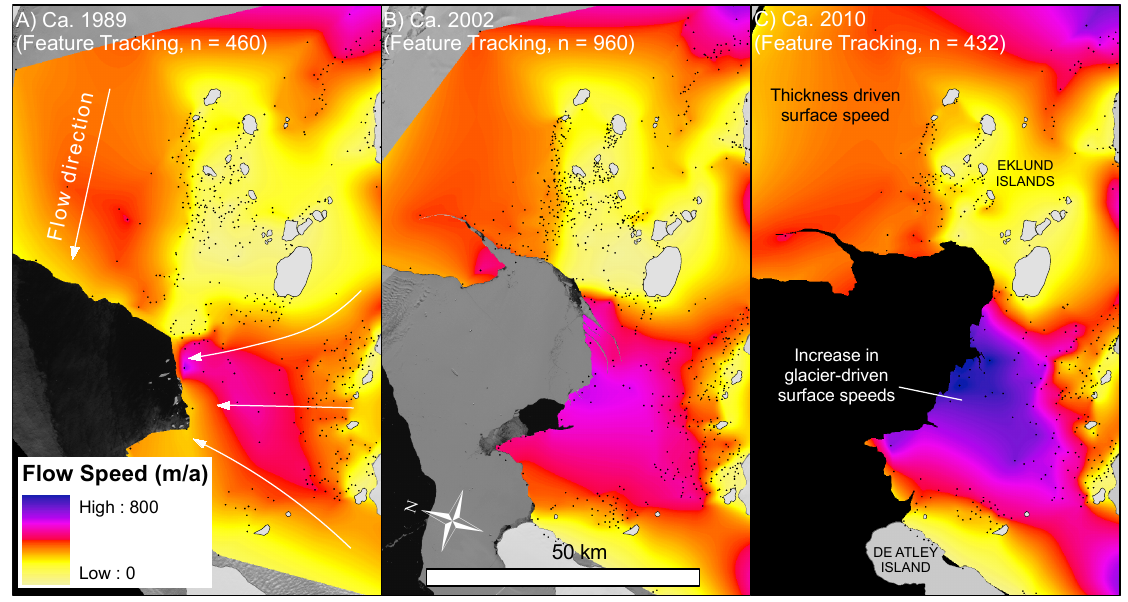
Fig. 7. Surface speed calculations at the south ice front for ca. 1989 (A) , ca. 2002 (B) and ca. 2010 (C) . There is a clear increase in speed between the Eklund Islands and De Atley Island from ca. 1989 to ca. 2010, whilst thickness-driven flow (Humbert, 2007) north of the Eklund Islands does not change over time. Black dots represent the centre point of tracked features used for interpolating surface speeds. Uncertainties: (A) ±30ma − 1 , (B) ±15ma − 1 , (C) 15±ma − 1